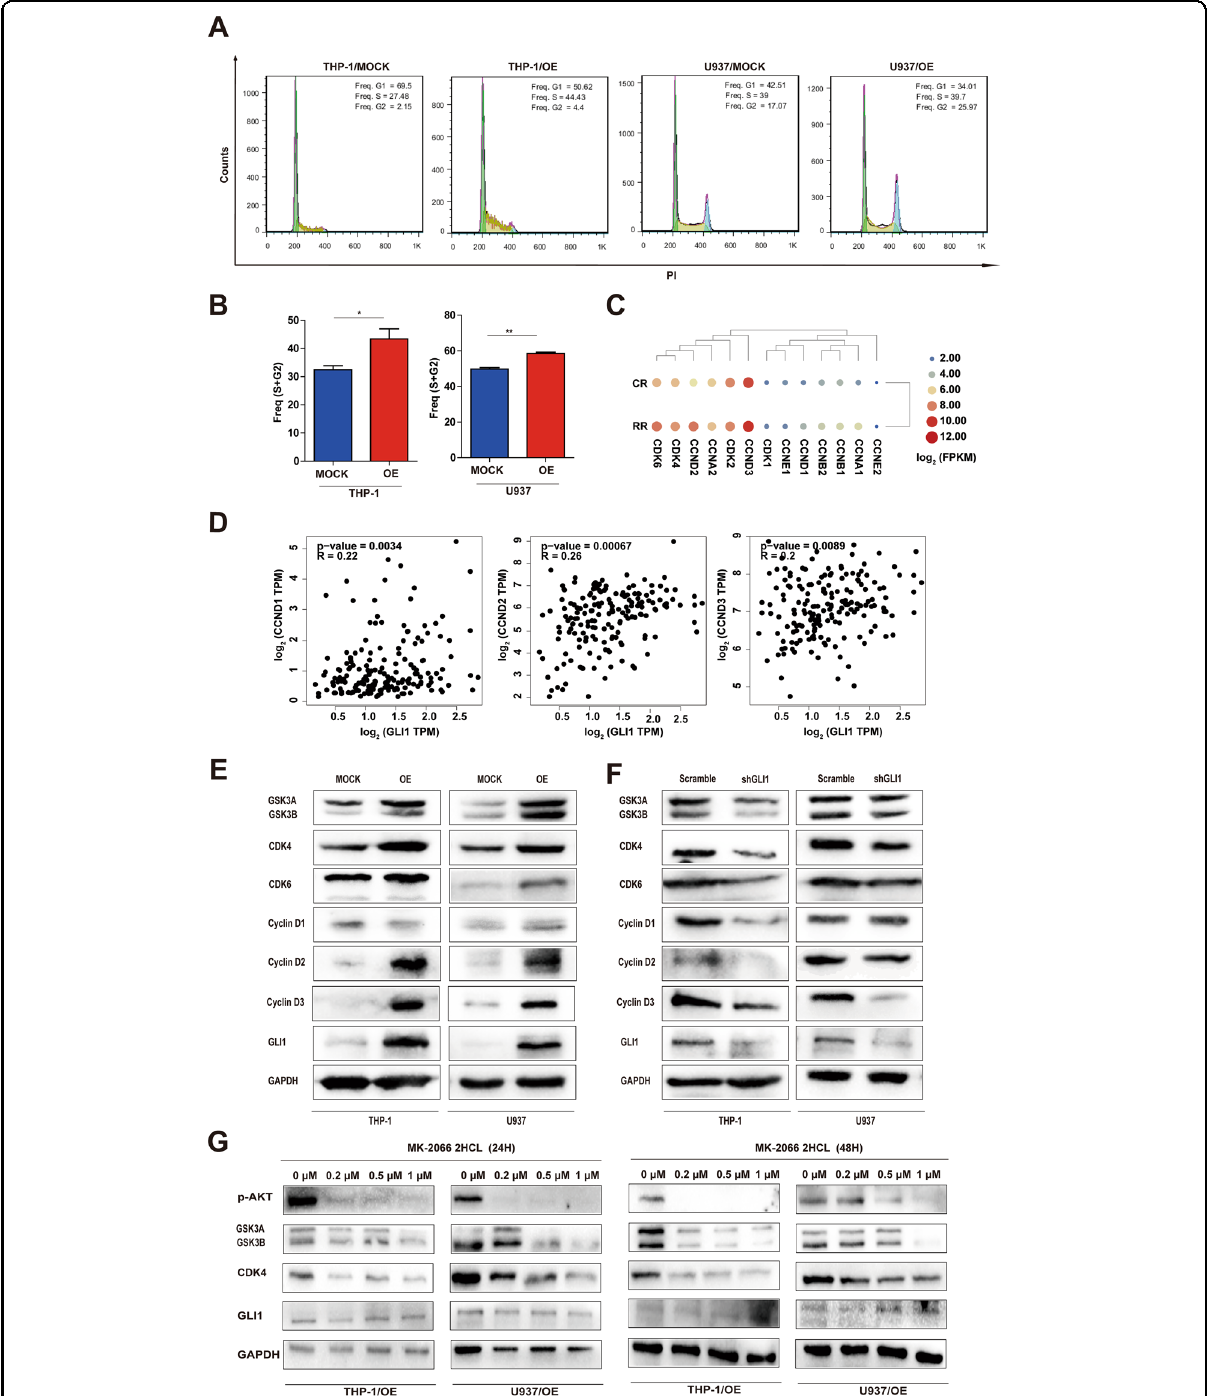
Fig. 2 Overexpression GLI1 up-regulates cyclins and cyclin-dependent kinases. A , B Representative histograms ( A ) and quanti fi cation ( B ) of cell cycle phases of THP-1 and U937 OE/MOCK cells by FACS analysis. C Differentially expressed cell cycle-related genes in AML-RR and AML-CR patients from analysis of RNA-seq data. D The correlation between GLI1 and cyclin Ds in AML patients was evaluated using a non-log scale for calculation and a log-scale axis for visualization. The coef fi cient of correlation ( r ) and the p -value is indicated. E , F Protein expression of GSK3A/B (51/47 kDa), cyclin D1/D2/D3 (36 kDa/32 kDa/33 kDa), CDK4 (34 kDa), and CDK6 (36 kDa) in THP-1 and U937 MOCK/OE cells ( E ) and THP-1 and U937 Scramble/ shGLI1 cells ( F ) by Western blot. G THP1/OE and U937/OE cells were treated with different concentrations of MK-2206 2HCL (0, 0.2, 0.5, and 1 μ M) for 24 h (left) and 48 h (right). Cell lysates were analyzed by Western blotting for the p-AKT (65 kDa), GSK3A/B, and CDK4 protein levels. P values were obtained by two-way ANOVA. * P < 0.05, ** P < 0.01, *** P < 0.001, ns not signi fi